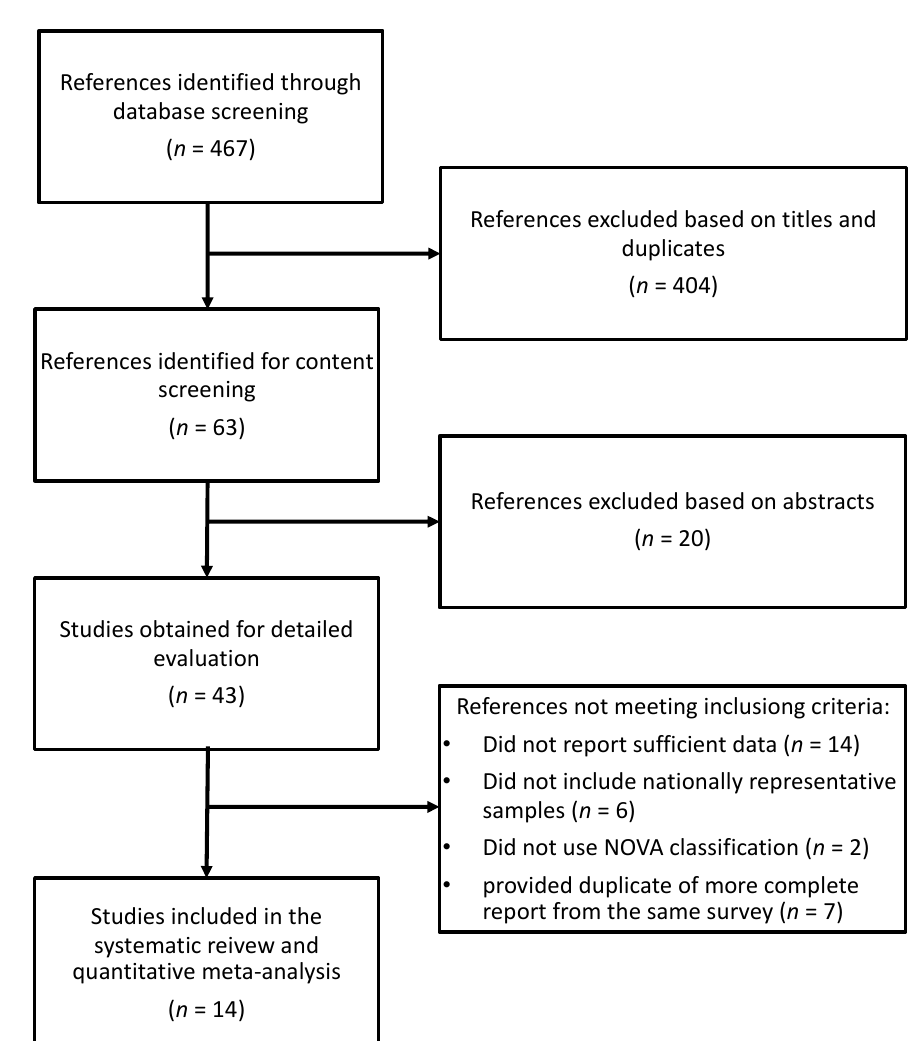
Figure 1. Screening and selection process for study articles exploring the distribution of foods and nutrients by quantiles of ultra-processed food intake (as a percentage of daily energy).